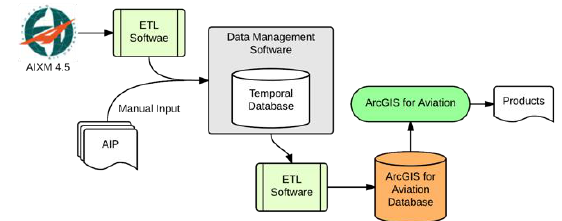
Figure 6. Data flow between data management software and GIS software